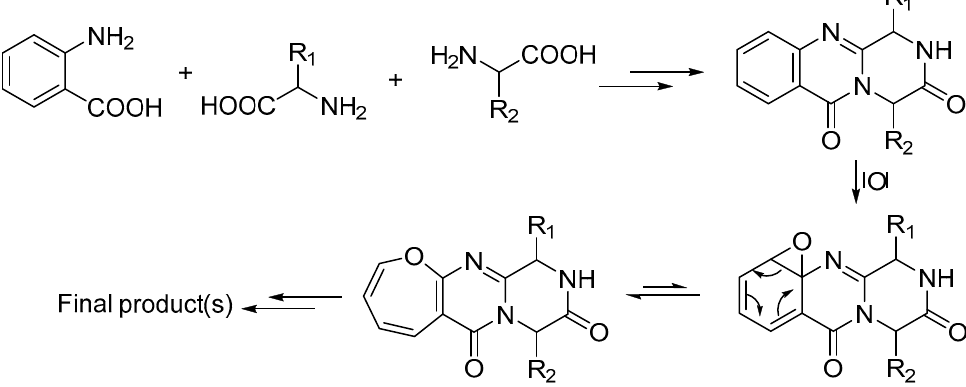
Figure 3. Proposed common biosynthetic steps of Oxepine-Pyrimidinone-Ketopiperazine NRPs.